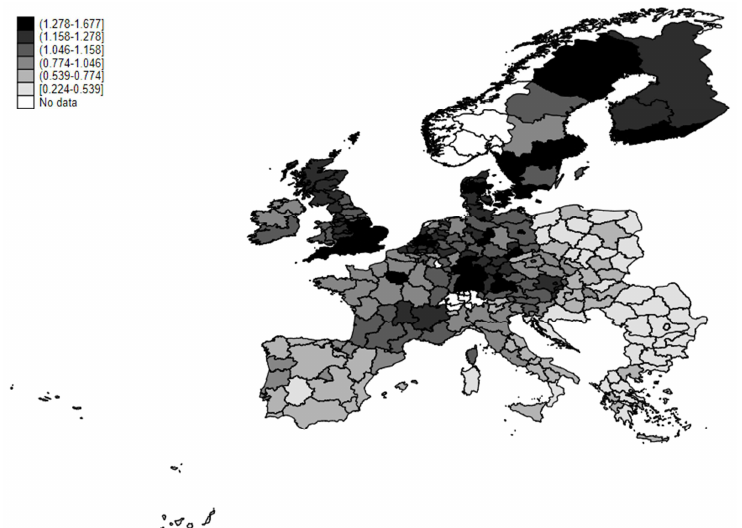
*For NUTS 1 regions the combined areas of NUTS 2 regions have been